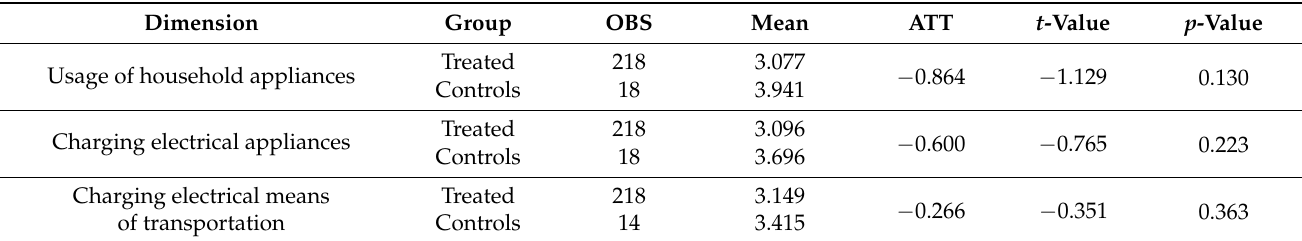
Table 4. Demand flexibility comparisons of Solar-owners (treated) versus Wind-owners (controls) (source: authors’ own